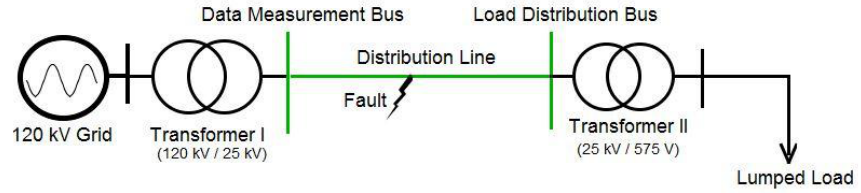
Figure 3. Four-node test distribution feeder used for fault location purpose. Table 2. Four-node test distribution feeder specifications.